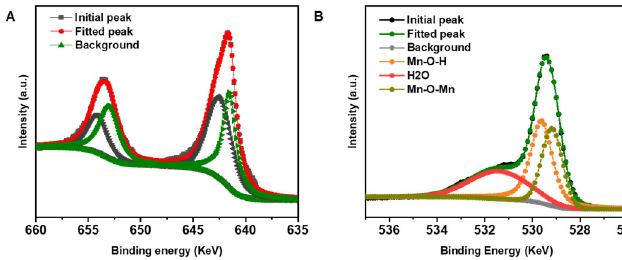
Figure 4. XPS spectrum of MnO 2: ( A ) is Mn2p and ( B ) is O1s.